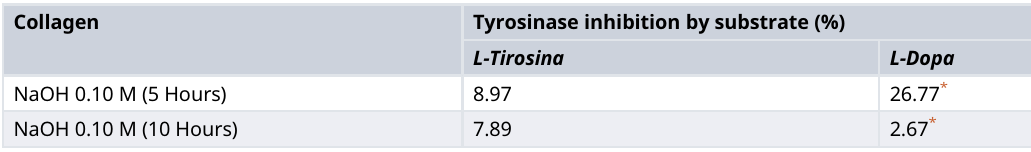
Table 5. Anti-tyrosinase activity of collagen at 1000 mg/L.